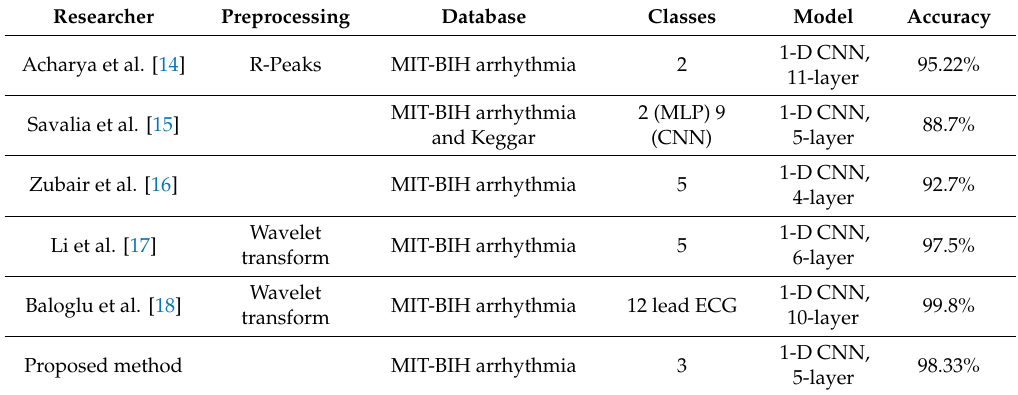
Table 1. Main techniques for classifying ECG signals based on the use of CNN